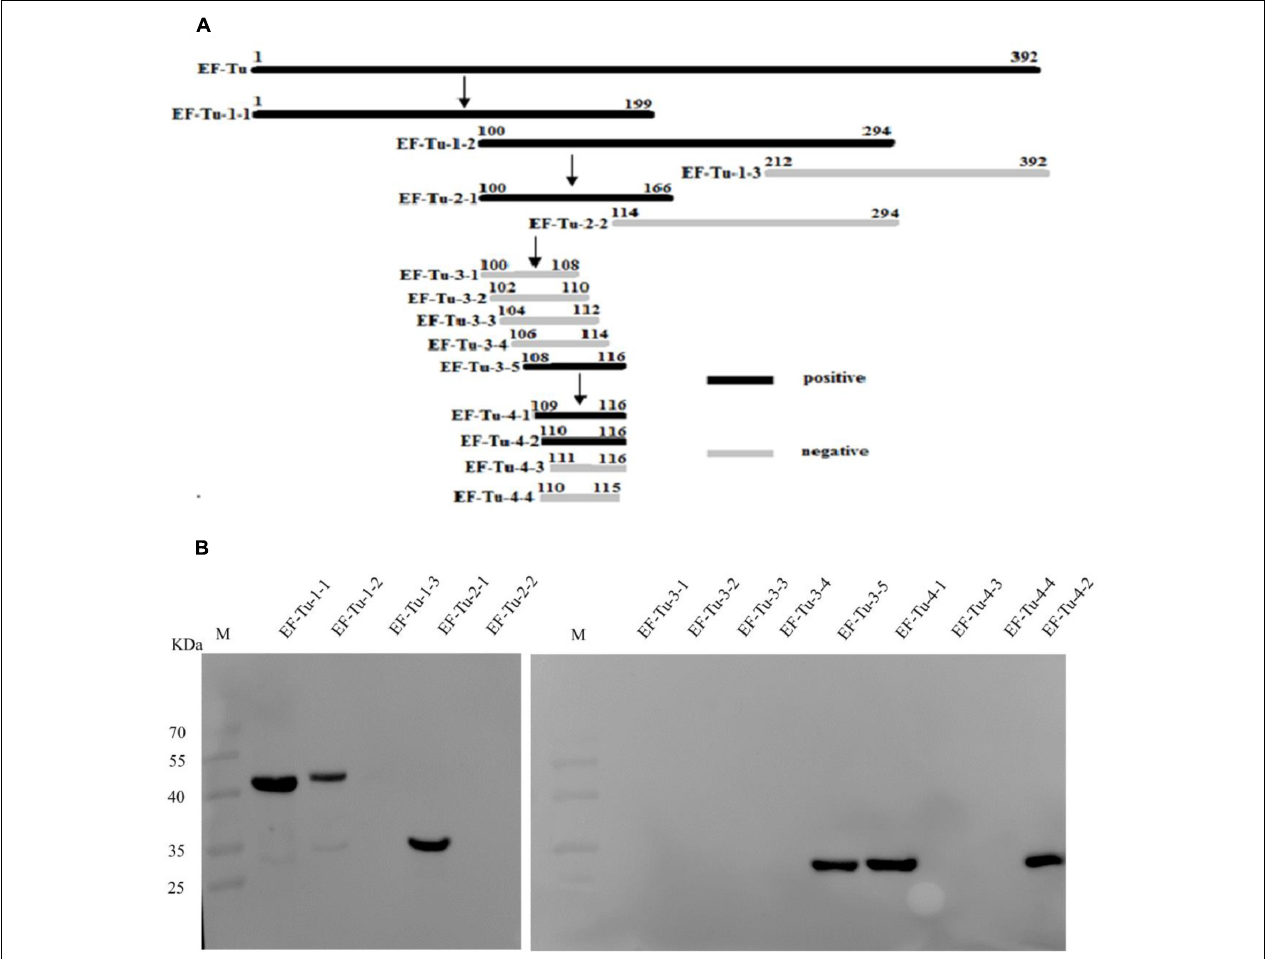
FIGURE 2 | Identification of epitope recognized by McAb BD 6 . (A) Summary design of overlapping fragments of EF-Tu, with accurate position of epitope recognized by McAb BD 6 deduced at 110 Gln Thr Arg Glu His Ile leu 116 in B. melitensis EF-Tu protein. (B) Analysis of various overlapping fusion proteins of EF-Tu expressed in E. coli BL21 (DE3) by western blotting using McAb BD 6 as primary